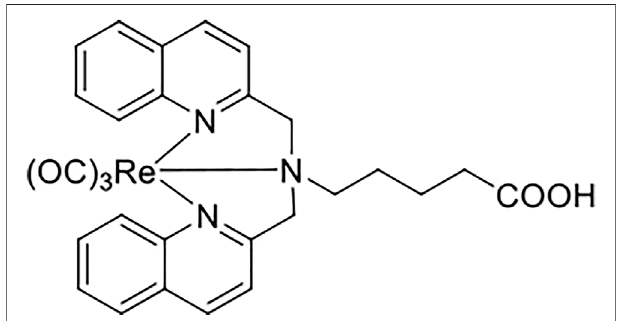
FIGURE 1 | Re(I) bisquinolinyl complex used in this study.